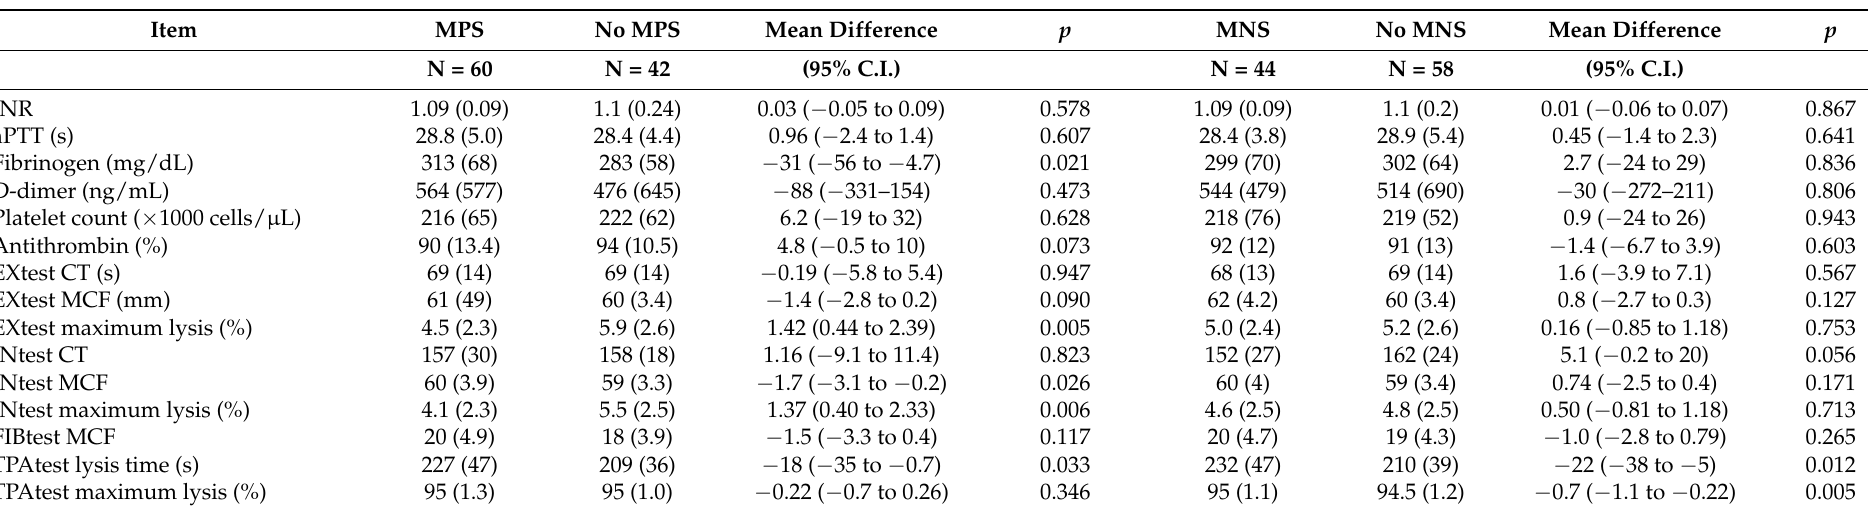
Table 2. Hemostatic profile at follow up according to the presence of persistent major physical or neuropsychological symptoms. N =